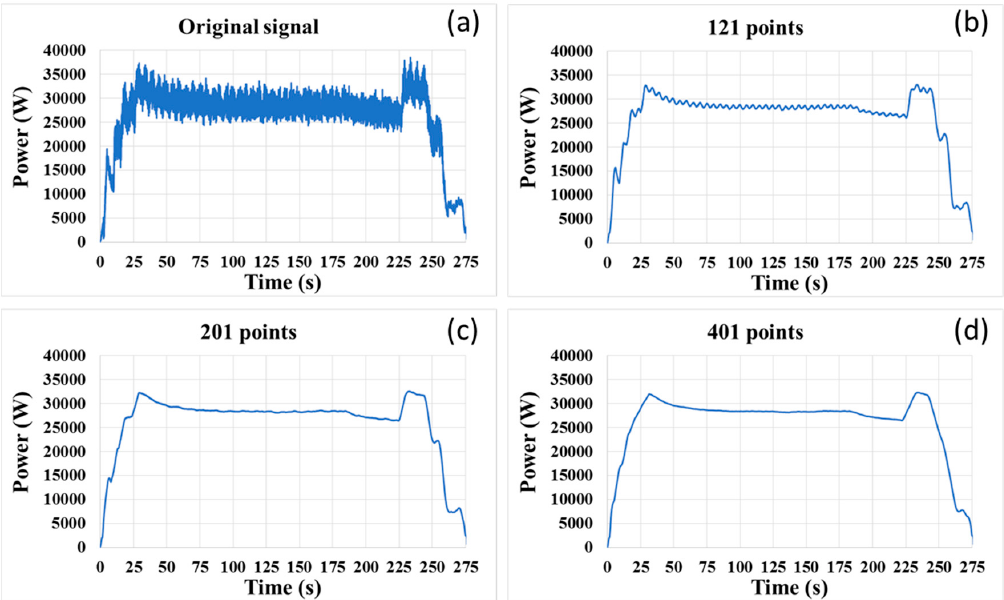
Figure 12. ( a ) Original signal; ( b ) Smoothed signal curve with 121-points moving window; ( c ) ( a ) Original signal; ( b ) smoothed signal curve with 121-points moving window; Smoothed signal curve with 201-points moving window; ( d ) Smoothed signal curve with 401-points ( c ) smoothed signal curve with 201-points moving window; ( d ) smoothed signal curve with 401-points moving window. moving